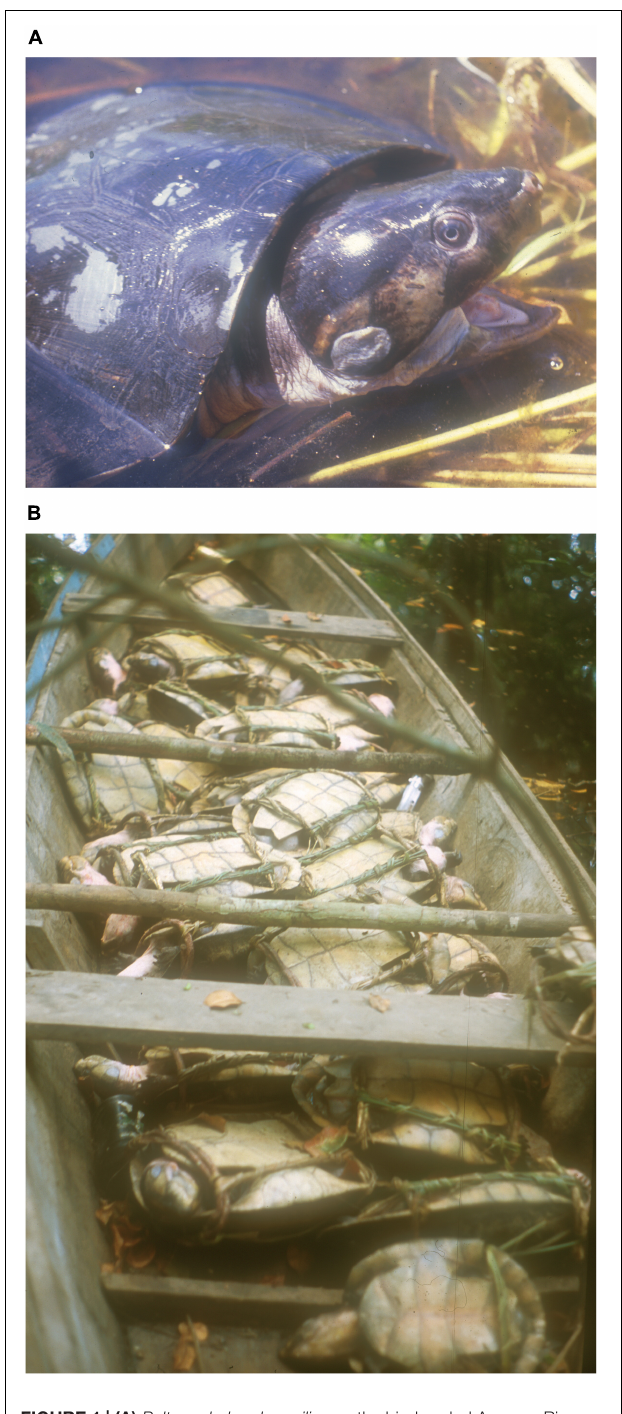
FIGURE 1 | (A) Peltocephalus dumerilianus , the big-headed Amazon River Turtle; (B) a quantity of big-headed turtles caught in Jaú National Park and destined for the illegal